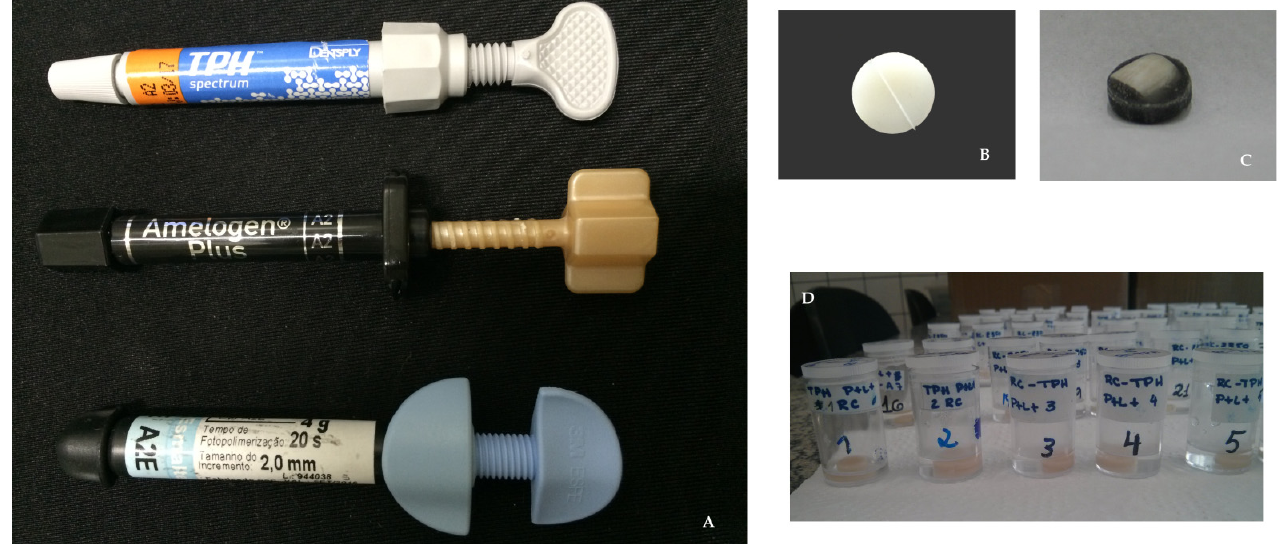
Figure 1. The composite resins used ( A ), resin ( B ) and bovine enamel ( C ) specimens, and the specimens randomization procedure ( D) . procedure ( D)